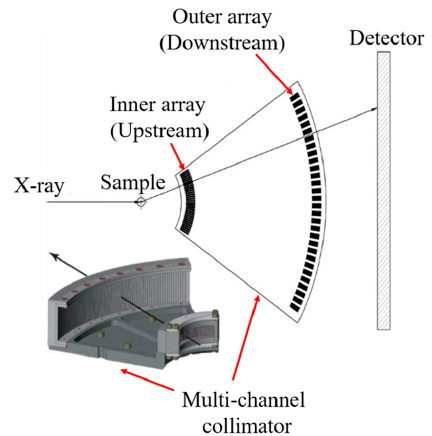
Figure 3. A multi-channel collimator is used for beam collimation on the X-ray scattering side. The inner and outer arrays, with slit opening widths of 0.05 and 0.2 mm, are composed of 75 slits with 0.8° separation. Schematic shows the basic concept of beam collimation (top view) (modified from [13]).